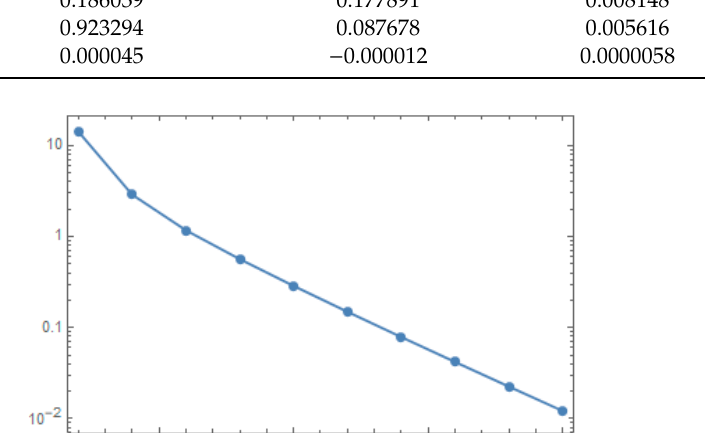
Figure 17. Comparison for lamina-shaped nanoparticles .